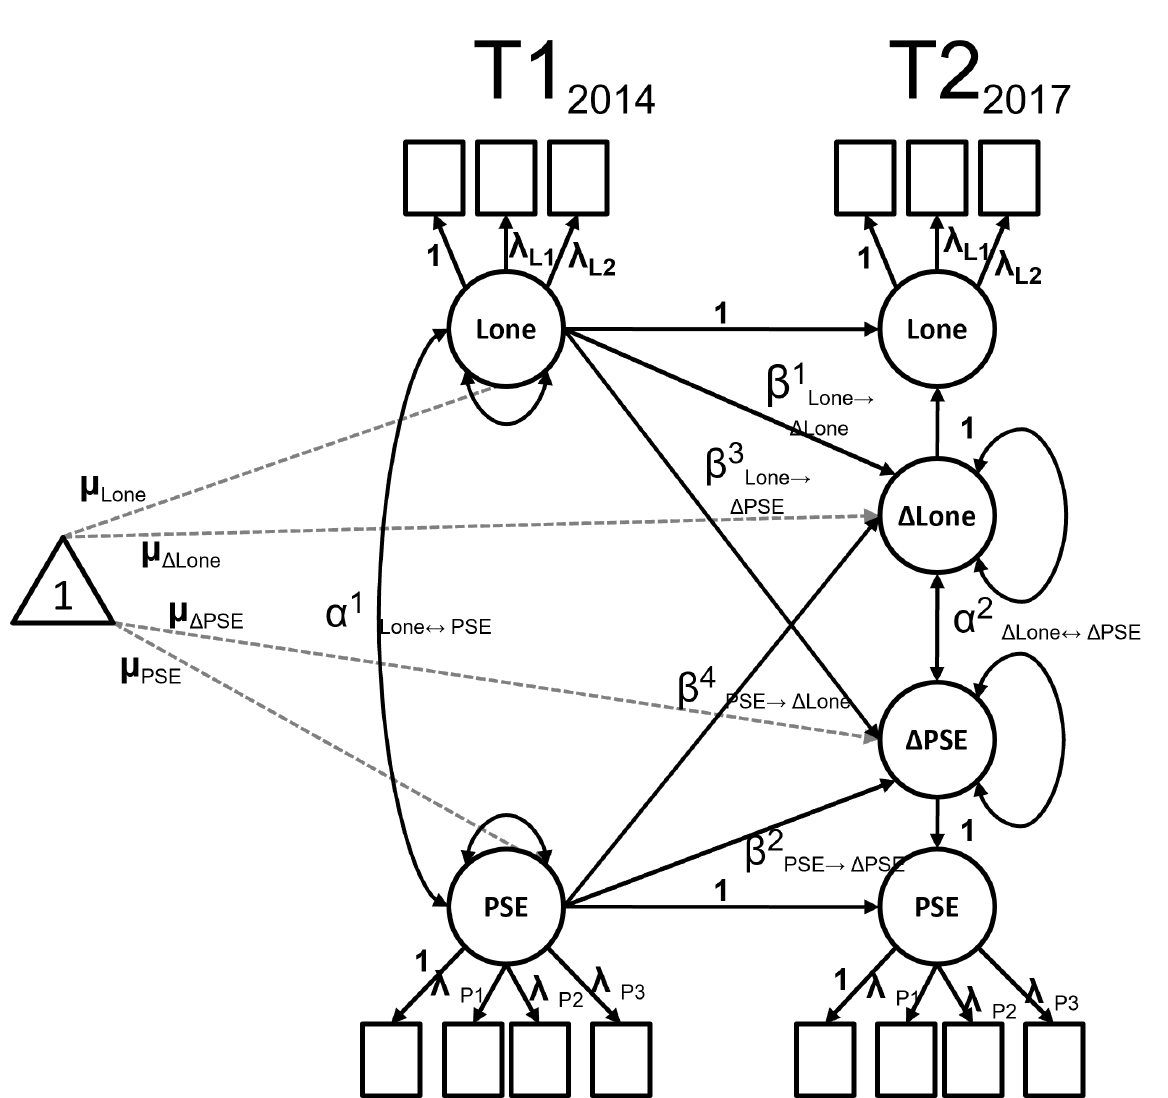
Figure 2: Dual change score model linking changes in PSE and loneliness. Notes: Lone = loneliness; ∆ = change; α = covariations; β = path coefficients; λ = factor loadings; µ = intercepts; T1 2014 = first assessment in 2014; T2 2017 = second assessment in